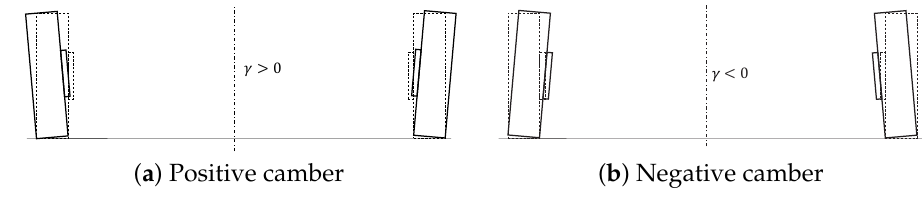
Figure 5. Camber angle sign definition.